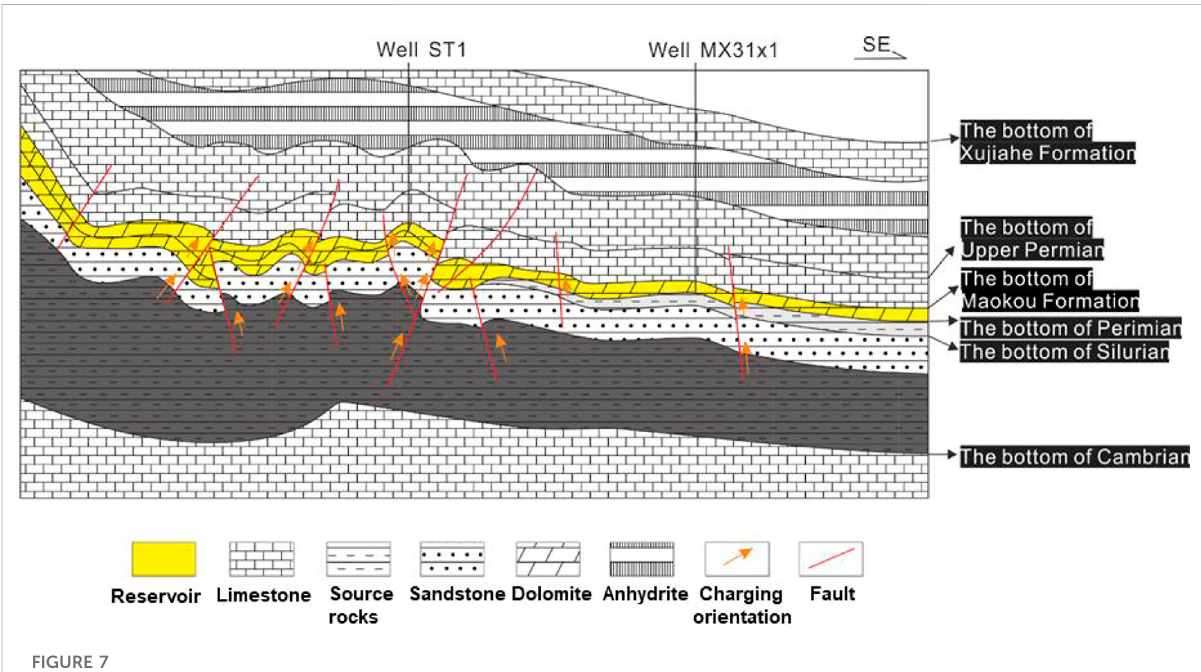
FIGURE 7 Oil and gas accumulation model of the Qixia